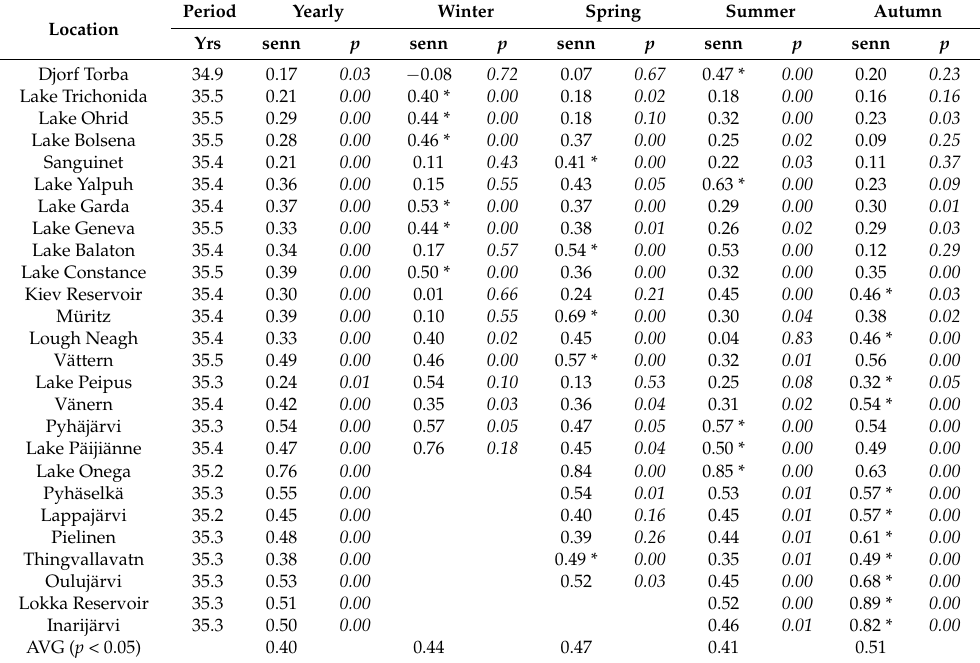
Table 7. Yearly and seasonal trends at all studied locations ordered from South to North. The covered period is slightly below the maximum of 36 years, depending on availability of cloud-free scenes at each location. The grayed-out values are trends (K/dec) in which Kendall p -value > 0.They are not retained to compute the average trends showed on the last line. The strongest seasonal trend of each lake is marked with an asterisk. Blank values signify that there were not enough values to compute trends, mostly due to ice cover during the cold